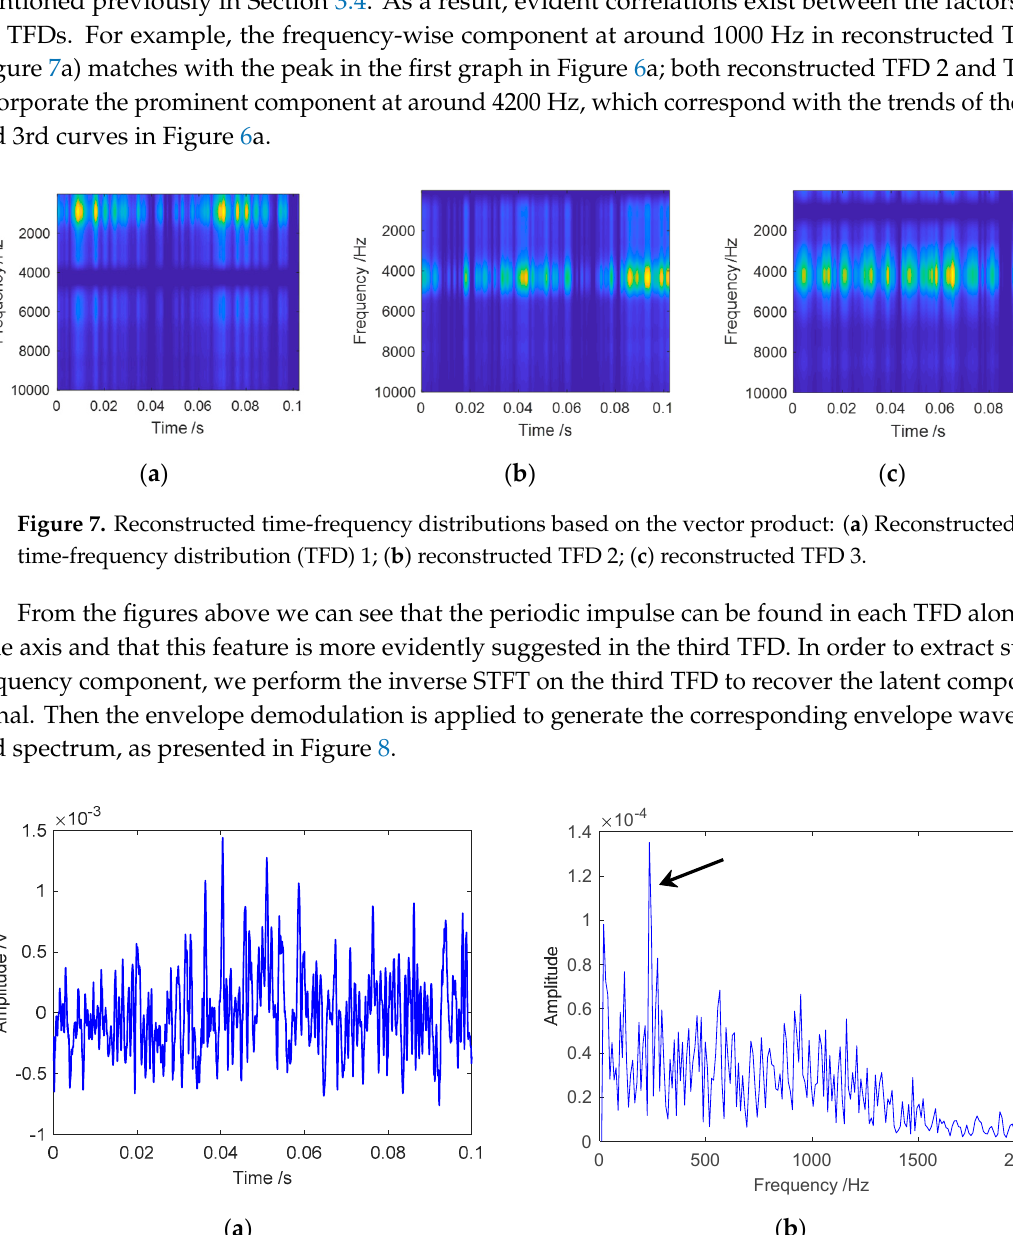
Figure 8. Results of the envelope demodulation: ( a ) The envelope waveform of latent component three; and ( b ) the corresponding envelope spectrum.